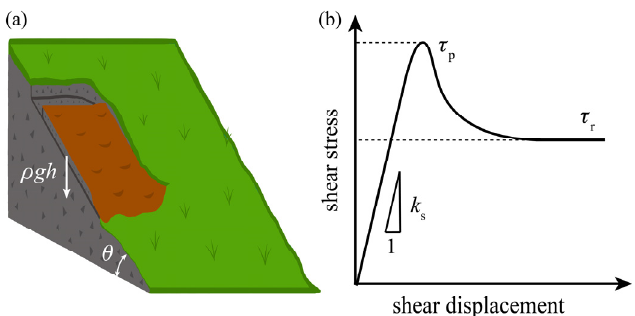
Figure 5. ( a ) Schematic of a land weighting ρ gh slide along the slope with the incline angle of θ ; ( b ) typical shear stress–displacement behavior of rocks in direct shear test, where τ p is the peak shear strength or the driving strength, τ r is the residual shear strength, and the initial slope of the curve, K s , is the shear stiffness.